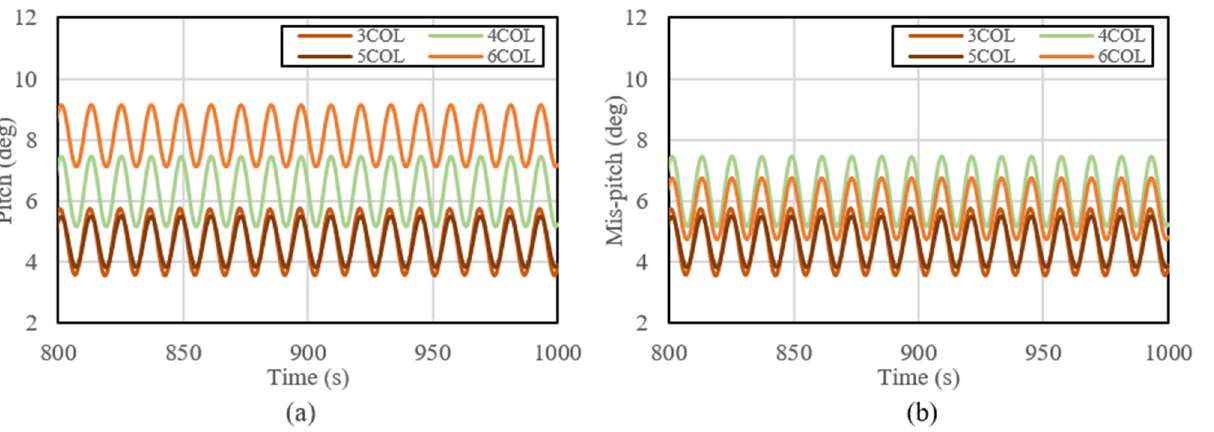
Figure 20. Pitch results for different types of platforms (( a ): direction of waves and wind aligned; ( b ): direction of waves and wind misaligned).